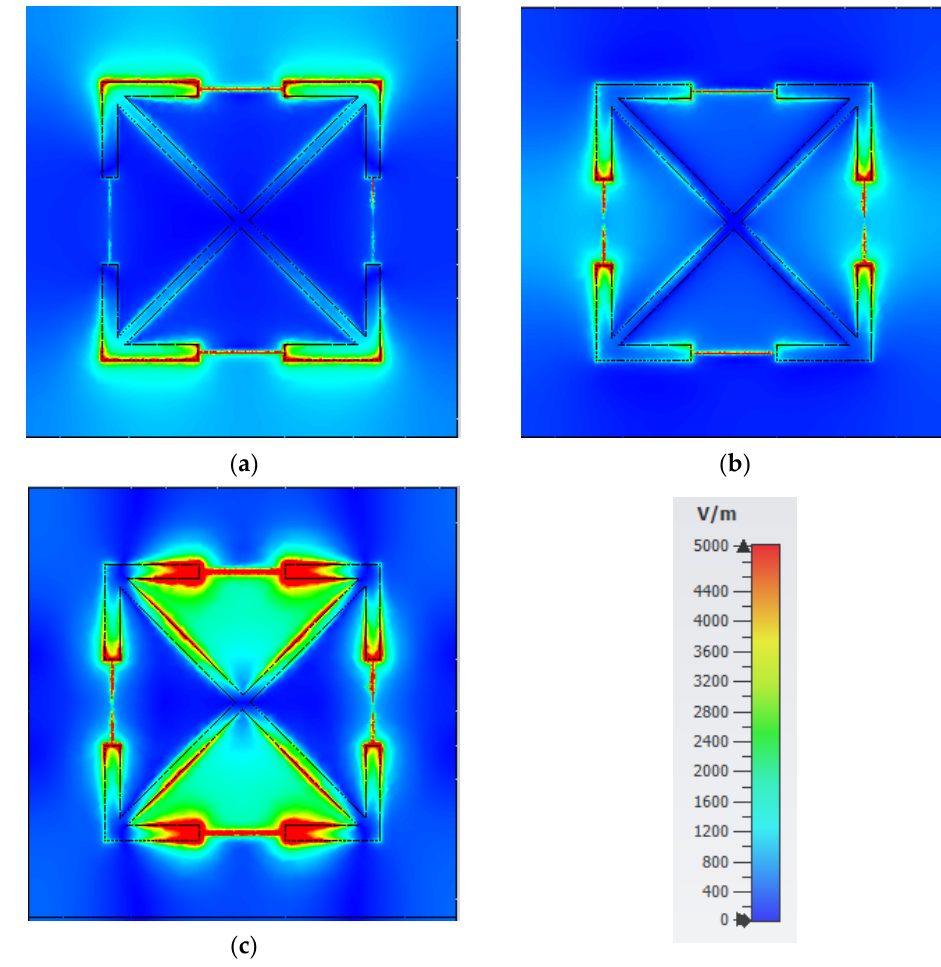
Figure 4. E-field distributions: ( a ) 2.09 GHz, ( b ) 4.34 GHz, and ( c ) 6.2 GHz.